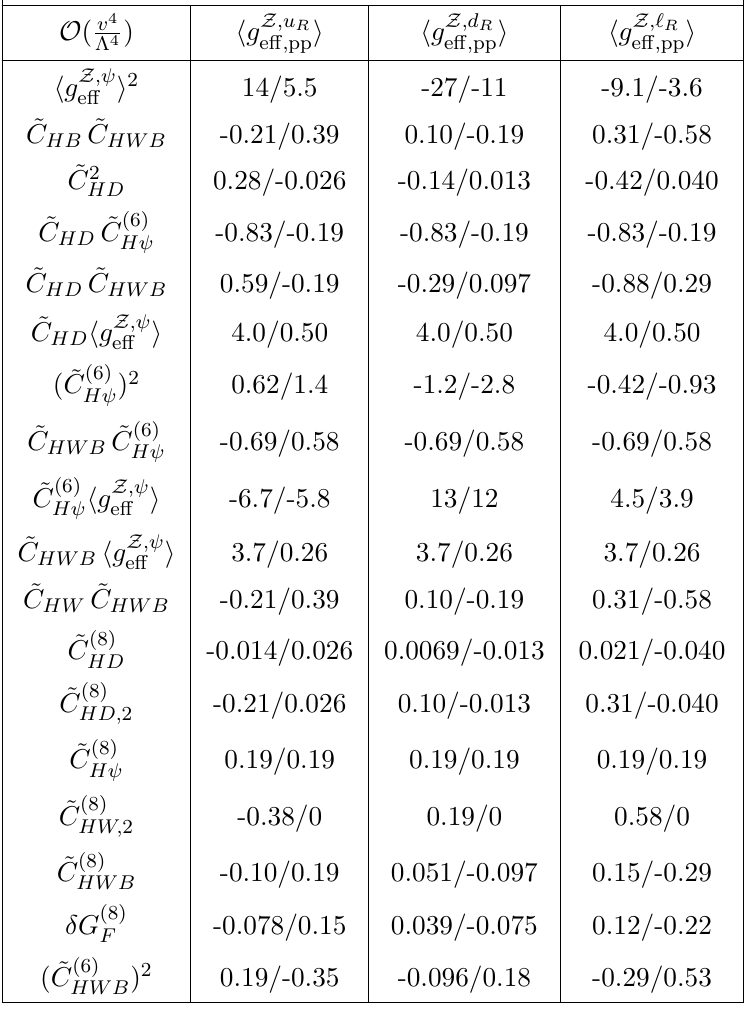
Table 6 . The effective couplings expanded to O ( v 4 / Λ 4 ) in each input parameter scheme. δG (8) and the remaining operator forms are defined in refs. [15,